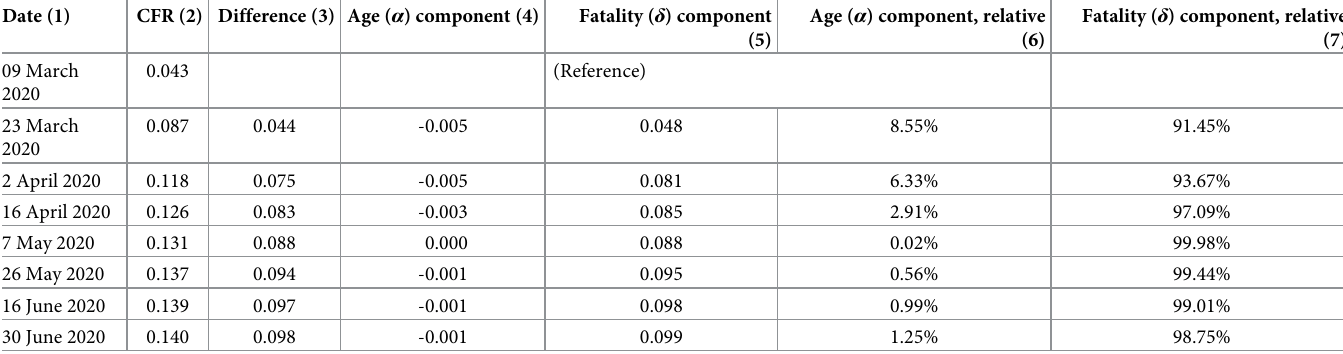
Table 3. Development of the Italian case-fatality rate (CFR) over time.